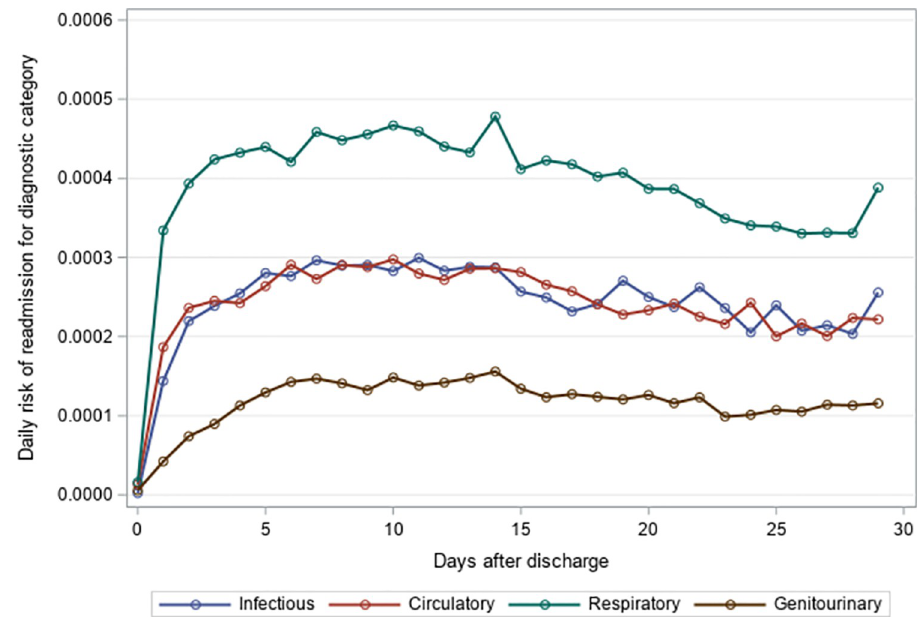
Fig 3. Daily risk of 30-day unplanned hospital readmission among older adults discharged to skilled nursing facilities following an index hospitalization for pneumonia, 2014–2015. Presents the daily risk of unplanned hospital readmission for four common causes of readmission (infectious, respiratory, circulatory, genitourinary). Each year started on the Sunday of Morbidity and Mortality Weekly Report week 27 and ended on the Saturday of Morbidity and Mortality Weekly Report week 26 of the following year.